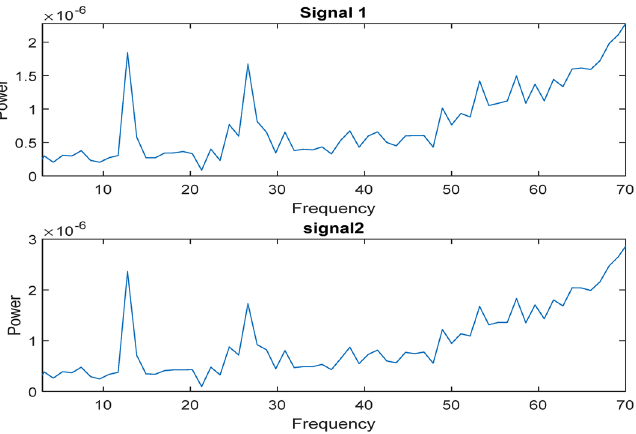
Figure 7. Power spectra of the input EEG Fp1 signal (signal 1) and the output signal from the corresponding neuron in the SNNr model, both filtered in the same way for a proper comparison of the